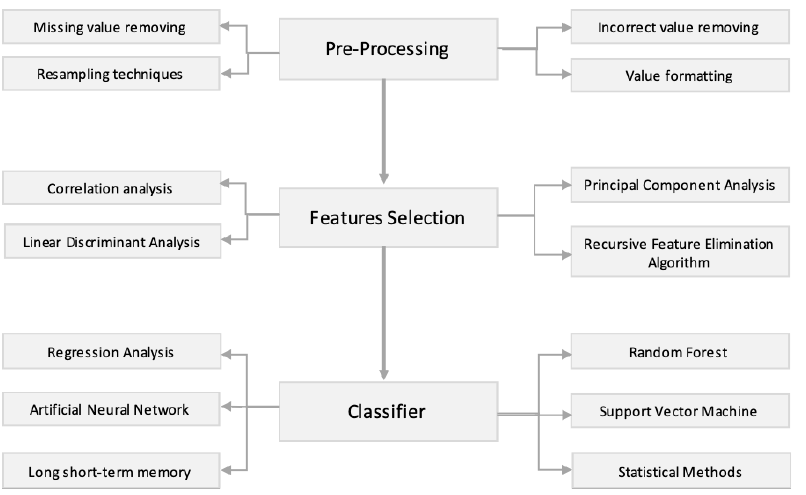
Figure 5. Techniques popularly explored in the domain of plant and crop disease prediction